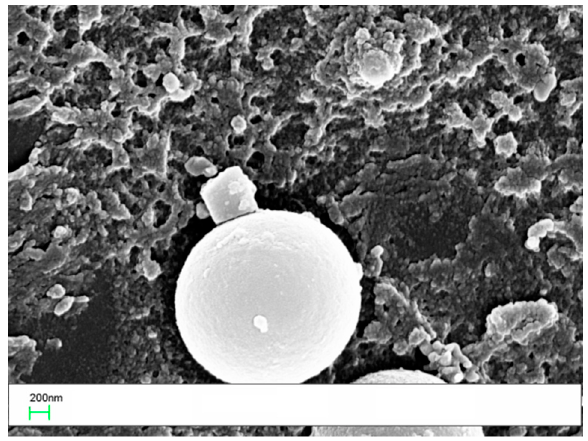
nanoscaled POSS (60,000×).